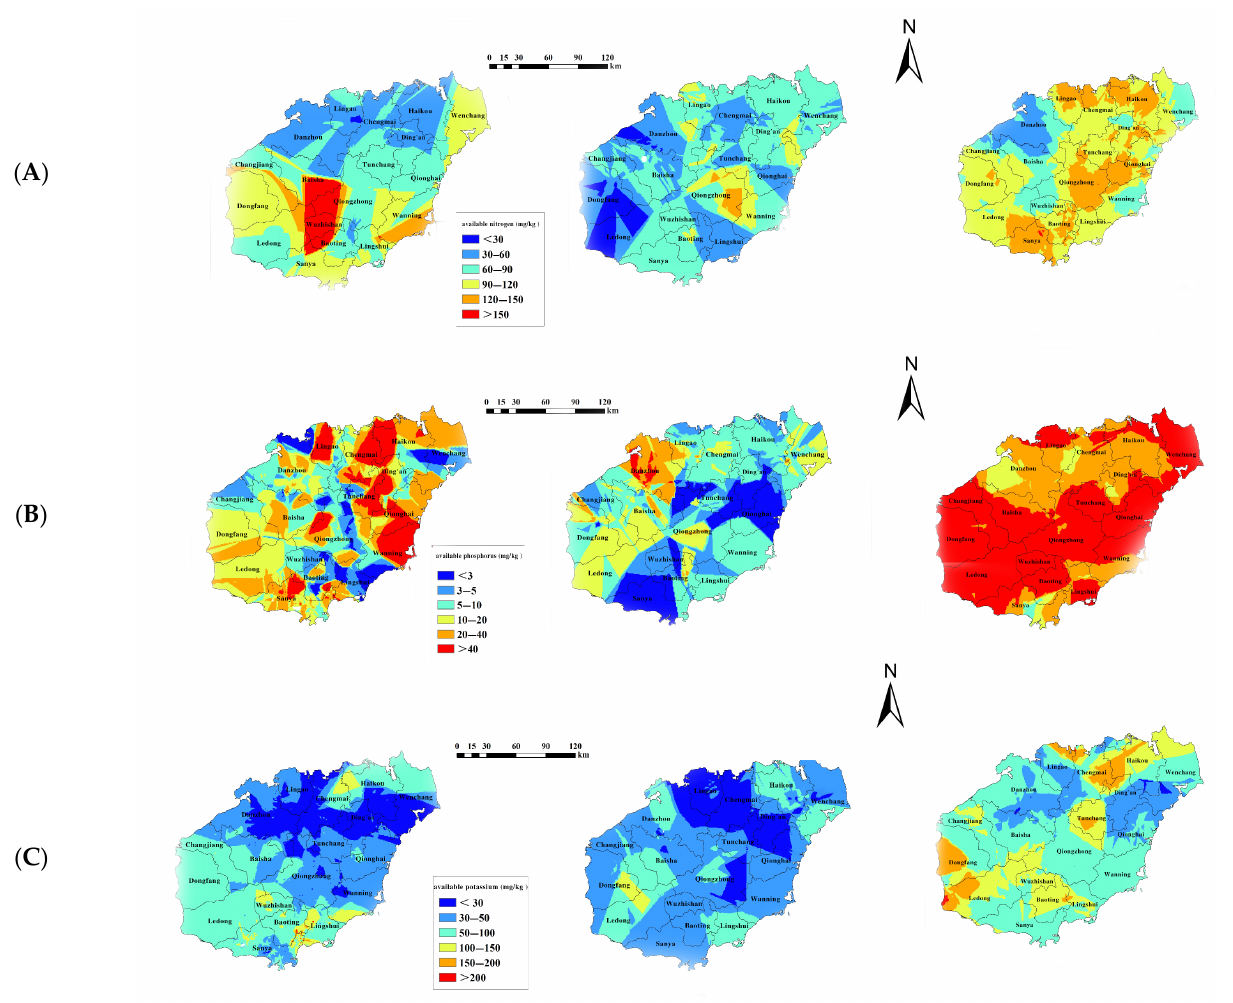
Figure 5. The spatial distribution of each indicator available nitrogen ( A ) at different stages. The spatial distribution of each indicator available phosphorus ( B ) at different stages. The spatial distribution of each indicator is available potassium ( C ) at different stages.